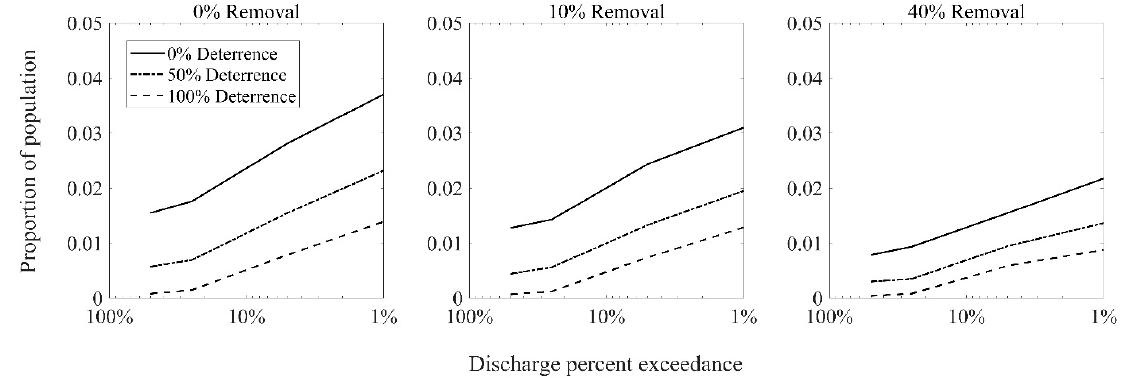
Figure 7. Proportion of silver carp passing two consecutive LDs equipped with non-physical deterrent systems with different efficacies and whose intermediate pool was subjected to carp removal.